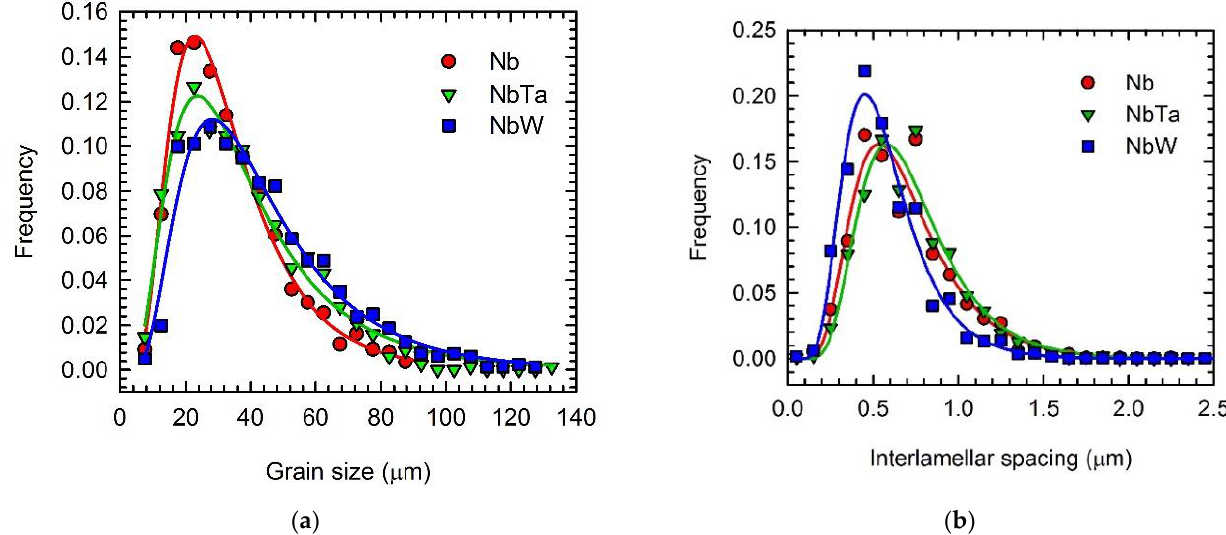
Figure 6. Measured grain size and interlamellar spacing in Nb, NbTa, and NbW alloys after tilt casting: ( a ) log-normal distribution curves of grain size, ( b ) log-normal distribution curves of α 2 - α 2 interlamellar spacing. The types of the distribution curves are marked in the figure.